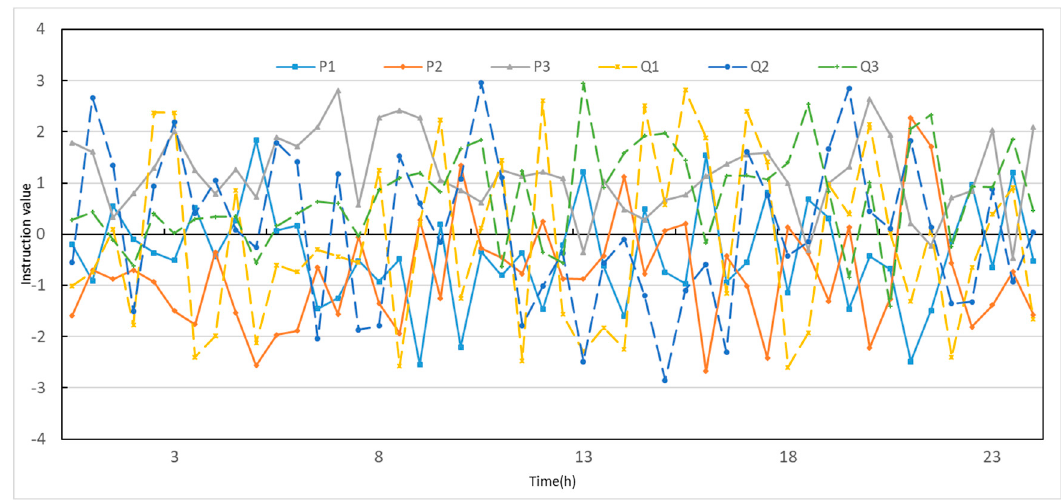
Figure 9. Flexible multi-state switch instructions in the optimization process. Table 2. Active and reactive command value of each port in the first 4